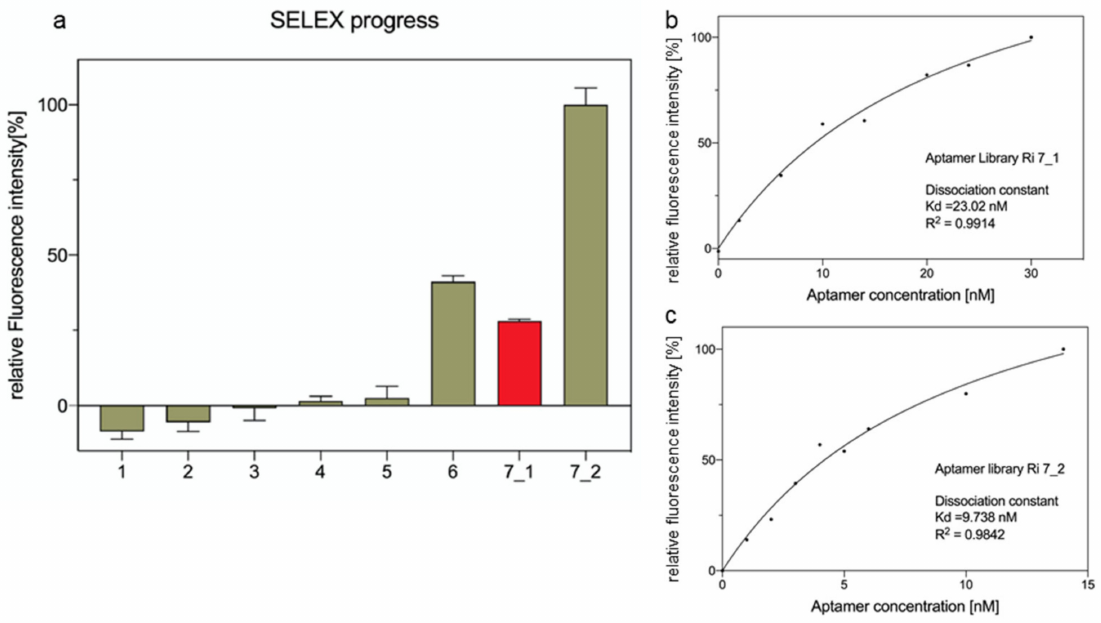
Figure 2. ( a ) Binding analysis of polyclonal aptamer library selectively targeting R. intestinalis . The progressively increasing fluorescence signal shows the enrichment of the aptamer library recognizing R. intestinalis (green-labeled). A different screening strategy was used in the seventh round of screening, and the aptamer library Ri 7_2 (green-labeled) showed a significantly enhanced ability to bind to R. intestinalis compared to the aptamer library Ri 7_1 (red-labeled). All experiments were conducted in triplicates ( n = 3); ( b ) The dissociation constant (K d ) of the polyclonal aptamer library Ri 7_1 was calculated as 23.02 nM, and the deviation of the coefficient of determination (R 2 ) was 0.9914; ( c ) The dissociation constant (K d ) of the polyclonal aptamer library Ri 7_2 was calculated as 9.738 nM, and the deviation of the coefficient of determination (R 2 ) was